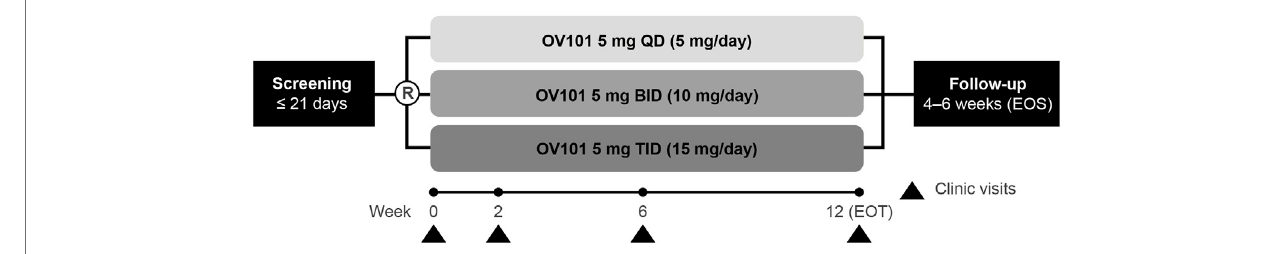
FIGURE 1 | Study design. R, randomization; OV101, gaboxadol; QD, once daily; BID, twice daily; TID, 3-times daily; EOT, end of treatment; EOS, end of